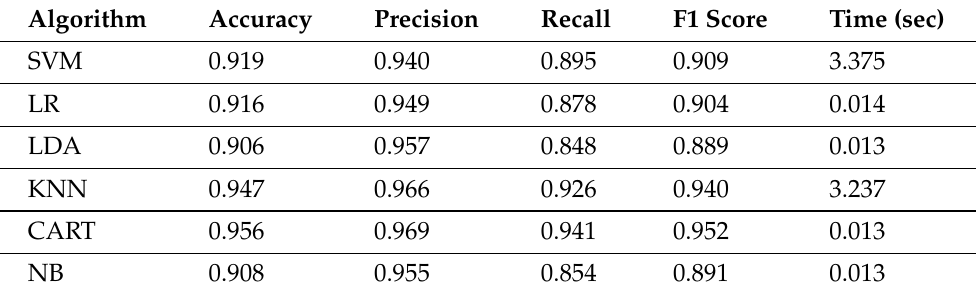
Table 2. Results using the Univariate Selection method.